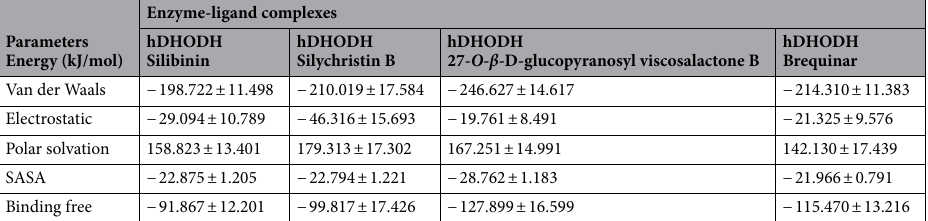
Table 2. MM-PBSA binding free energies of hDHODH with compound silibinin, silychristin B, 27- O-β -D- glucopyranosyl viscosalactone B and brequinar between 80 and 100 ns.